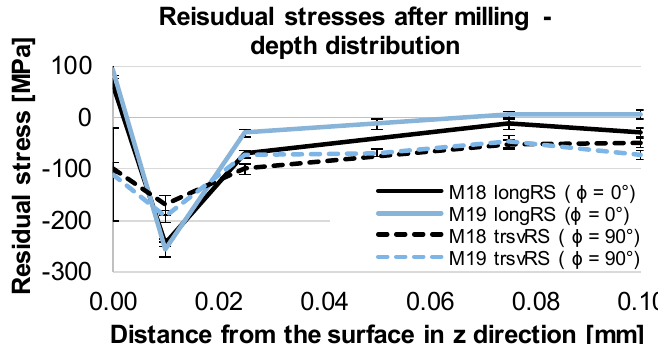
Figure 3. Residual stress depth distribution of milled specimens.